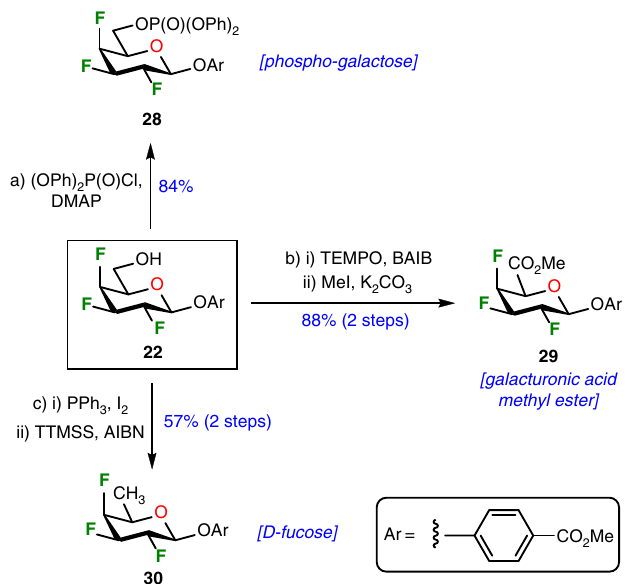
Fig. 4 Derivatization of 2,3,4-tri fl uorinated galactopyranoside 22 . Reagents and conditions: (a) ClP(O)(OPh) 2 (1.5 equiv.), DMAP (1.5 equiv.), CH 2 Cl 2 , rt, 16 h, 84%; (b) (i)TEMPO (0.2 equiv.), BAIB (2.5 equiv.), CH 2 Cl 2 /H 2 O, rt,